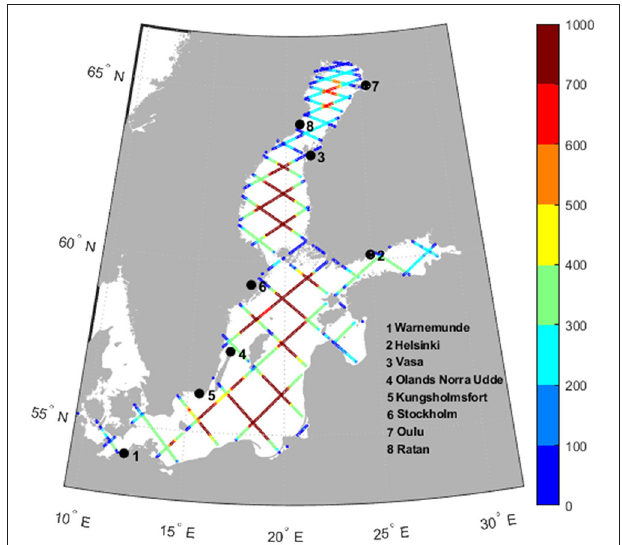
FIGURE 1 | The collinear data of Topex/Poseidon and follow-on missions for the Baltic Sea. The color bar reflects the number of valid measurements in each of the bins. Only one-third of the bins are suitable to be used in trend analyses when they are constrained to have at least 75% of measurements (700–1000 on the color bar). The locations of the tide gauge stations are also marked on the